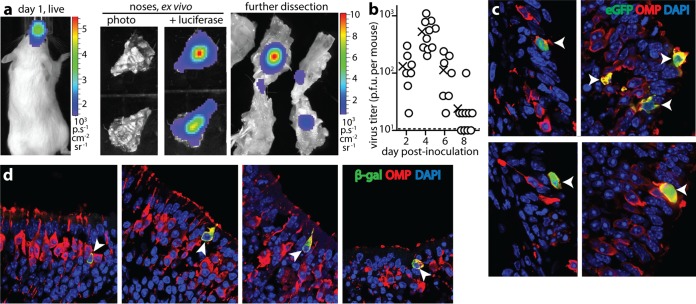
Identification of the nasal entry target. (a) Dissecting live image mice 1 day after i.n. M78-LUC revealed nasal infection. Further dissection localized signals to the nasal sinuses. The images shown are representative of the images for six mice. (b) Plaque assay of C57BL/6 pup noses after i.n. MCMV-GR (3 × 104 PFU). The circles represent values for individual mice. The means are indicated by × symbols. (c) Nose sections of C57BL/6 pups given MCMV-GR i.n. (105 PFU) 3 days earlier were stained for viral eGFP expression and olfactory marker protein (OMP) after 3 days. Nuclei were stained with DAPI. All eGFP+ cells were OMP+ (white arrowheads). The image shown is representative of the images for 12 mice. (d) Noses of pups given gL− MCMV i.n. (105 PFU) were stained 1 day later for viral β-galactosidase (β-gal) and OMP. All β-galactosidase-positive cells were OMP+ (white arrowheads).The images shown are representative of the images for six mice.